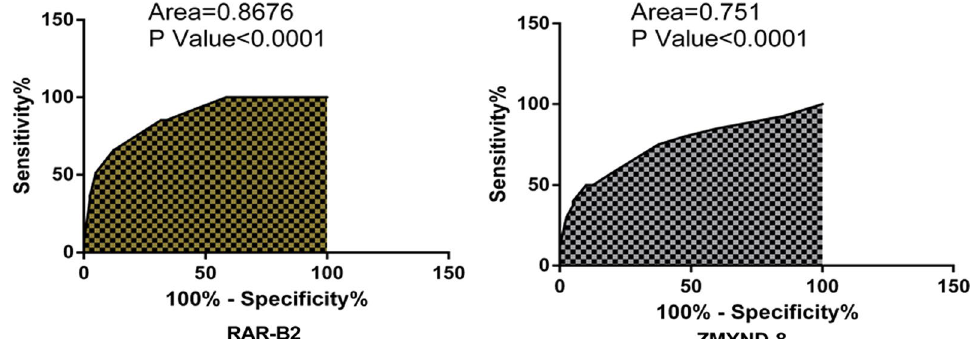
Fig. 3 ROC curve analysis; ROC curve analysis was performed on NSCLC samples for ZMYND-8 that showed a promising diagnostic value. ROC curve analysis was performed on NSCLC samples for RAR-B2 accuracy as a diagnostic biomarker for NSCLC as well